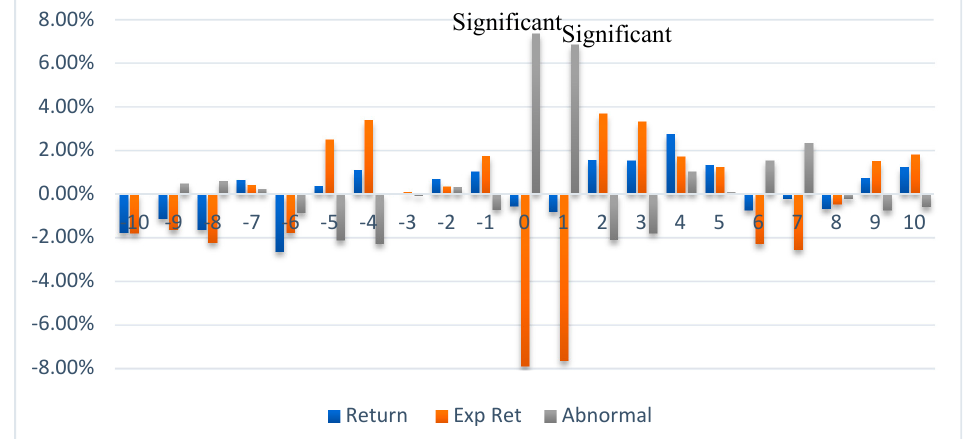
Figure 3. European Equity ETF.